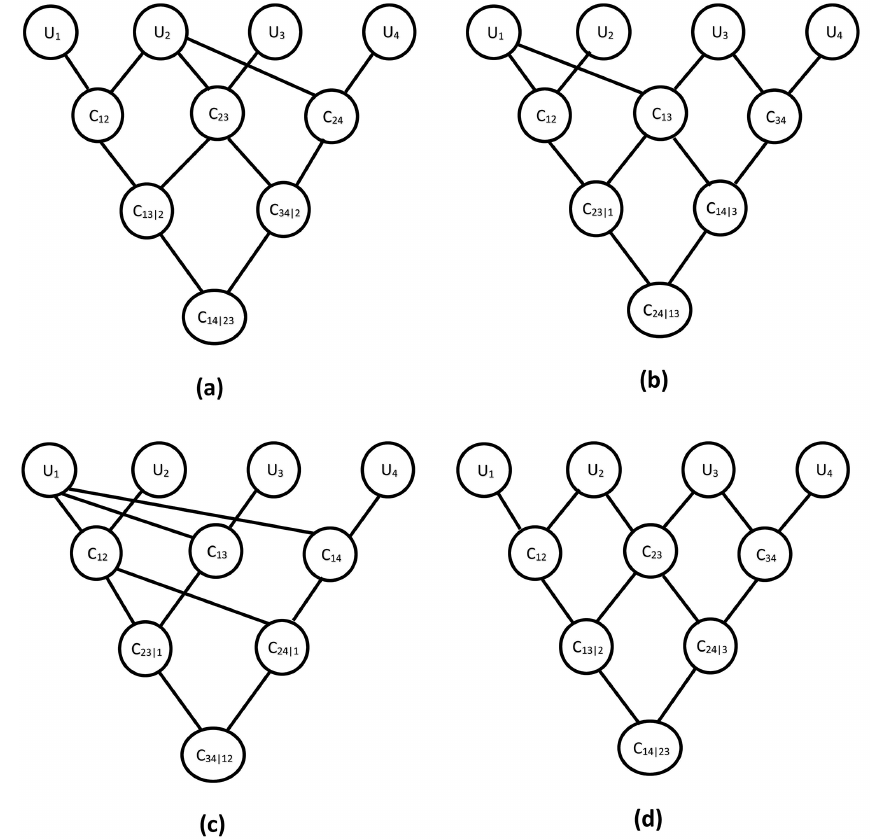
Figure 2. Examples of four-dimensional vine copulas: (a, b) regular vine copulas, (c) canonical vine or C-vine copula and (d) D-vine